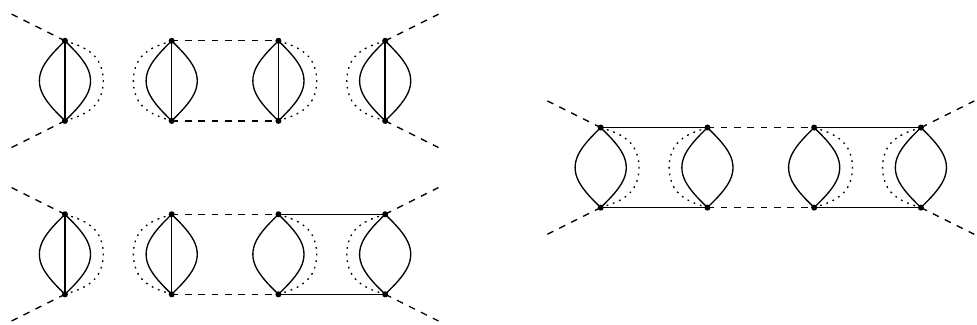
Figure 3 . Leading order graphs renormalizing the ~ (cid:21) and ~ (cid:21) p couplings respectively.